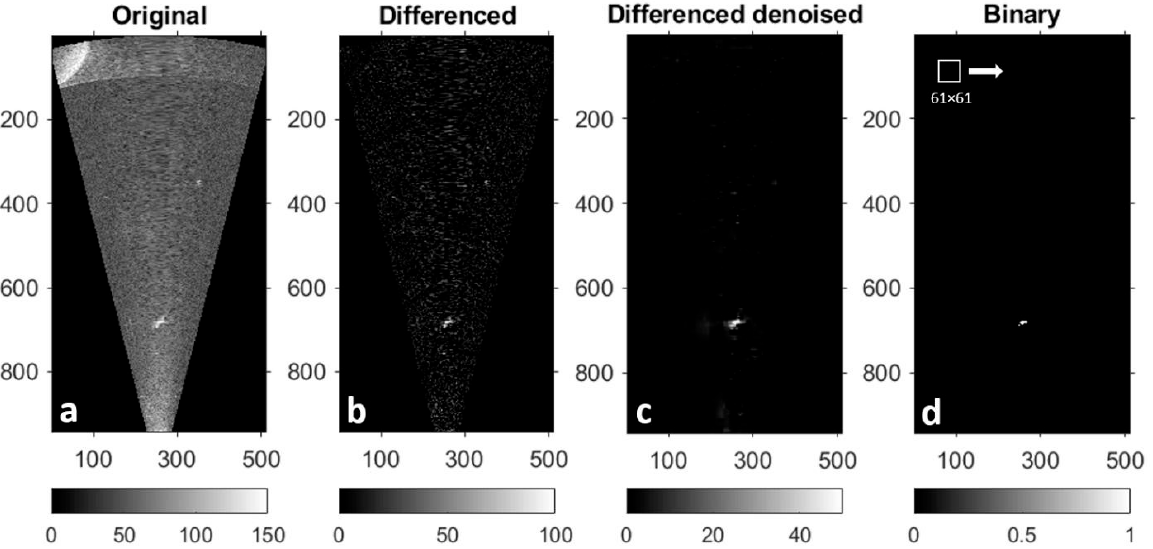
Figure 2. The workflow of sonar image processing and object extraction. ( a ) The original image in regular-grid was converted from the .aris file. ( b ) The differenced image was obtained by subtracting the mean of four adjacent frames from the current frame. ( c ) The differenced image was denoised using a wavelet transform. ( d ) The denoised image was transformed into a binary image with a threshold in pixel intensity. A sliding window of 61 × 61 pixels moved from the upper left to the bottom right of the binary image to screen potential objects of interest. The horizontal and vertical axes denote the pixel numbers of each image. Grayscale bars denote the pixel intensities.